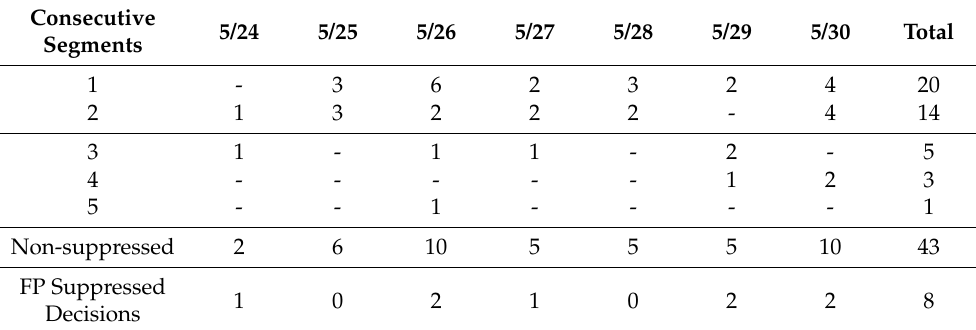
Table 9. Positively classified segments and final decisions to turn on the vaporizer during in situ